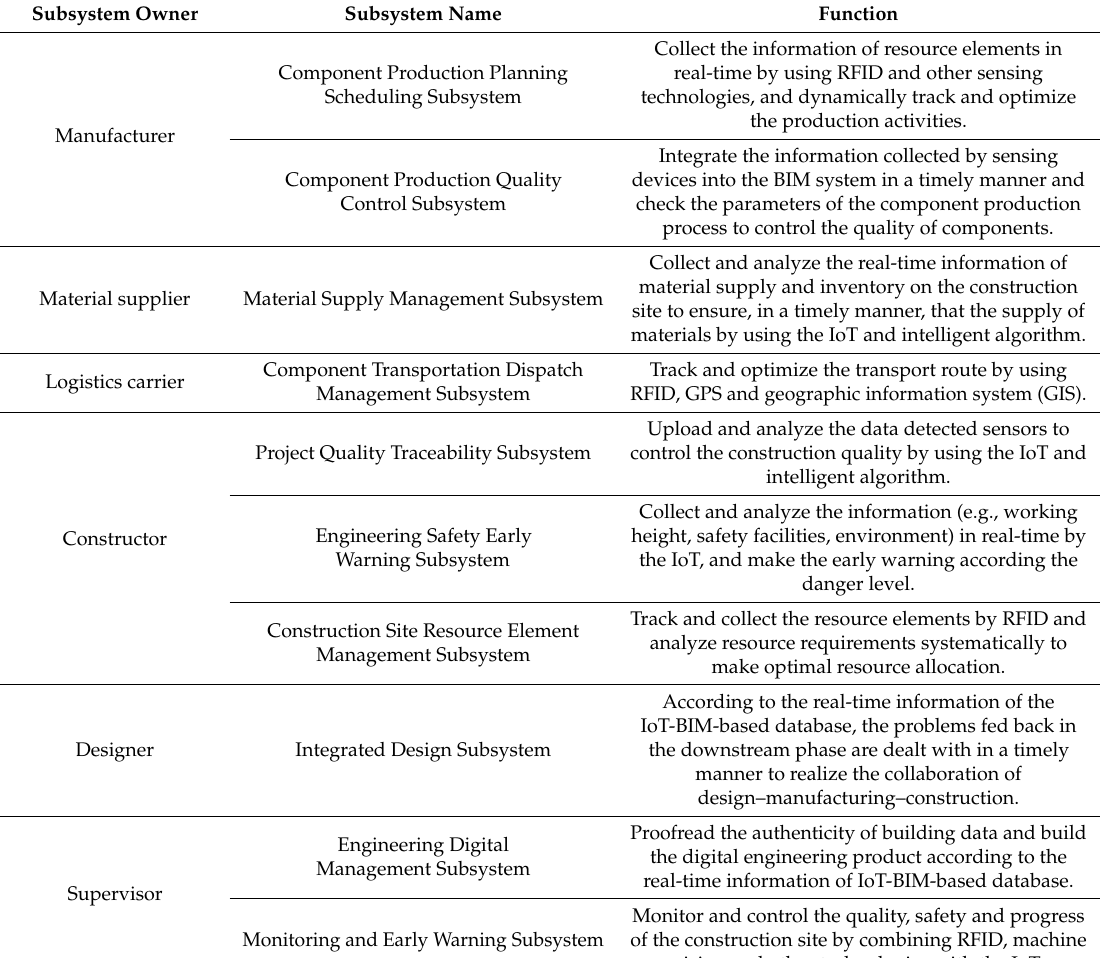
Table 3. Subsystem developed by